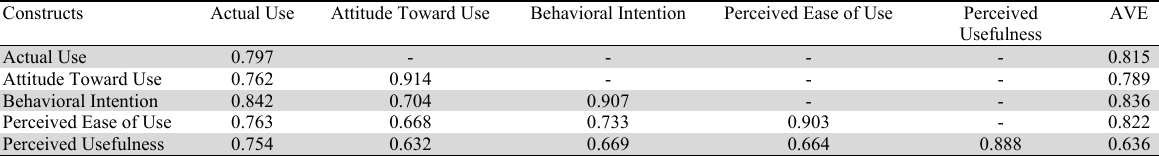
Convergent Validity (AVE) and Discriminant Validity Constructs